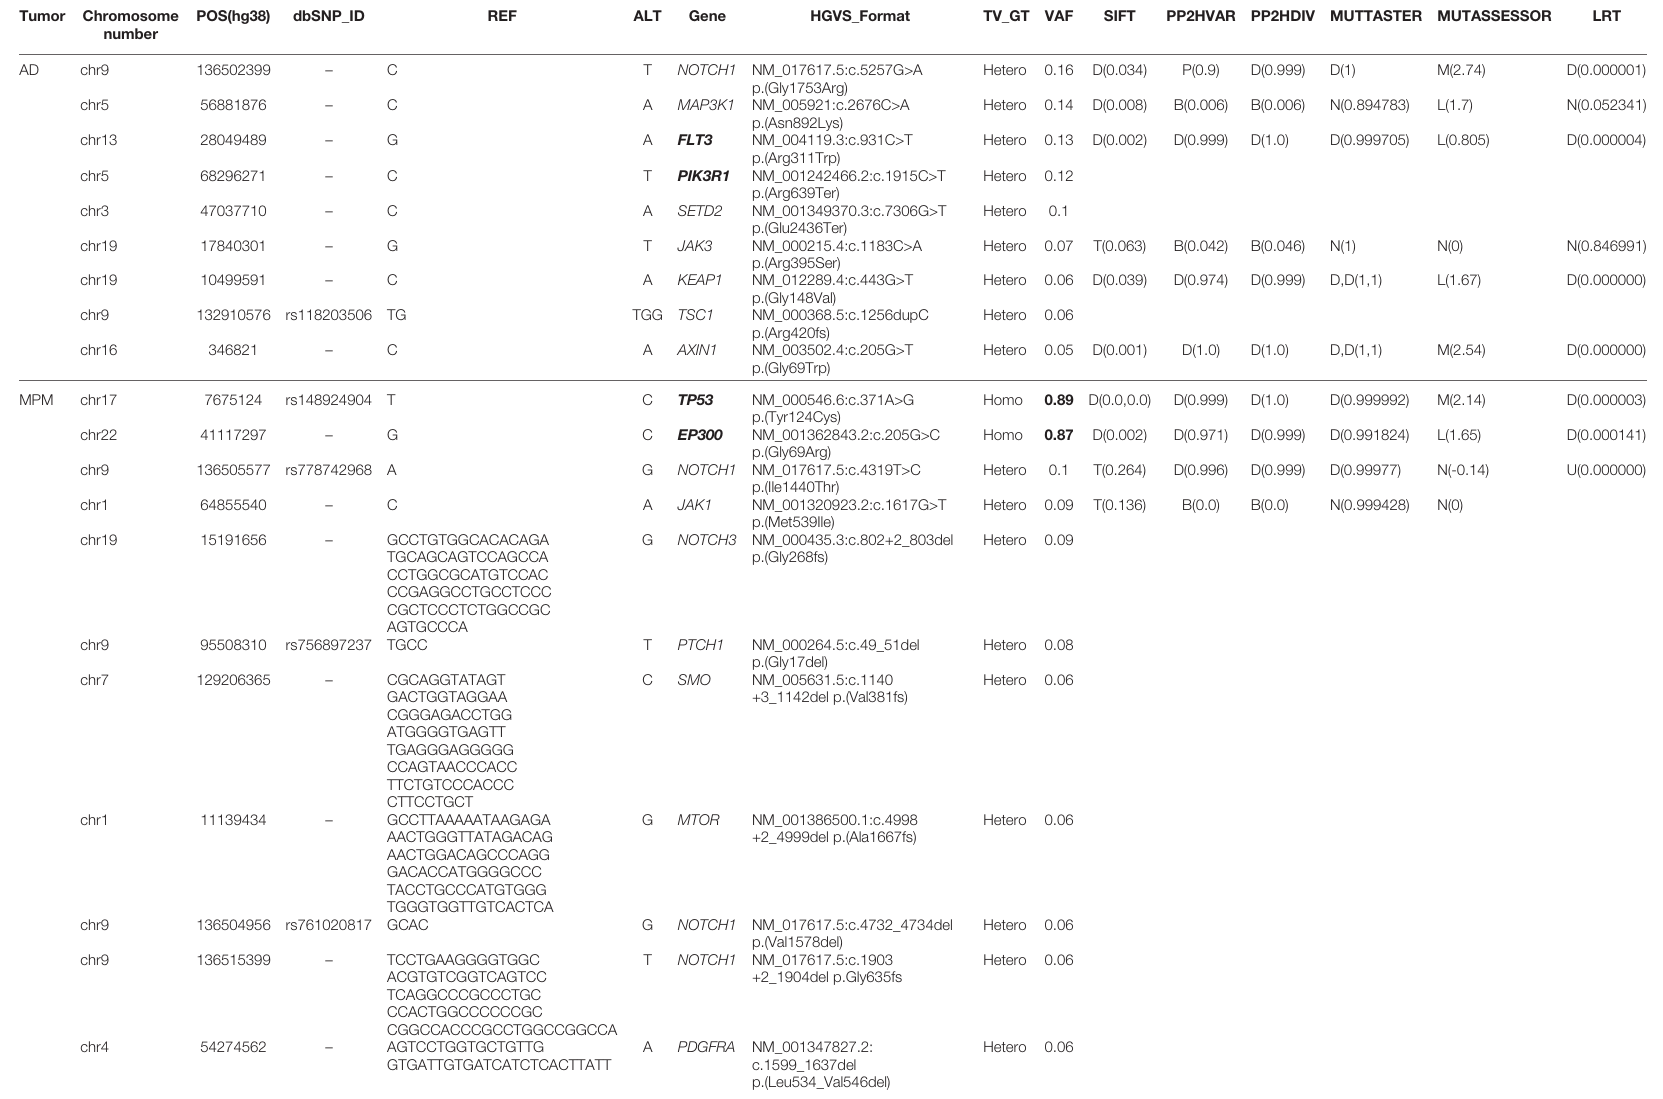
TABLE 1 | Suspicious pathogenic variants detected by cancer gene panel. Tumor Chromosome